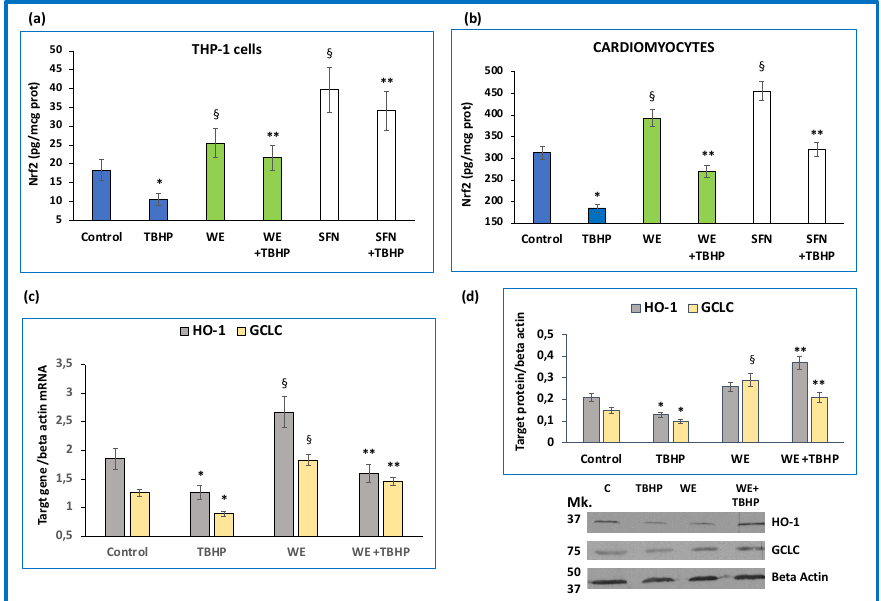
Figure 5. Wine metabolites activate Nrf2/ARE pathway in basal conditions and in cells exposed to oxidative stress. ( a , b ) Effect of wine extract (WE) and sulforaphane (SFN) on Nrf2 nuclear translocation. THP-1 cells and cardiomyocytes were pre-incubated with WE, containing 800 µ g/mL of total polyphenols and 10 µ M SFN with or without the addition of tert-butyl hydroperoxide (TBHP, 100 µ M). ( c ) Effect of WE on mRNA expression of Nrf2 target genes hemeoxygenase-1 (HO-1) and glutamate-cysteine ligase catalytic subunit (GCLC). ( d ) Average quantification of HO-1 and GCLC protein expression obtained by densitometric analysis and representative Western blot analyses for HO-1 and GCLC protein expression in cardiomyocytes. Data represent the mean +/ − standard deviation of measurements performed in triplicate in three different experiments and ; * p < 0.01 decrease vs. control; § p < 0.01 increase vs. control; ** p < 0.01 vs. TBHP.